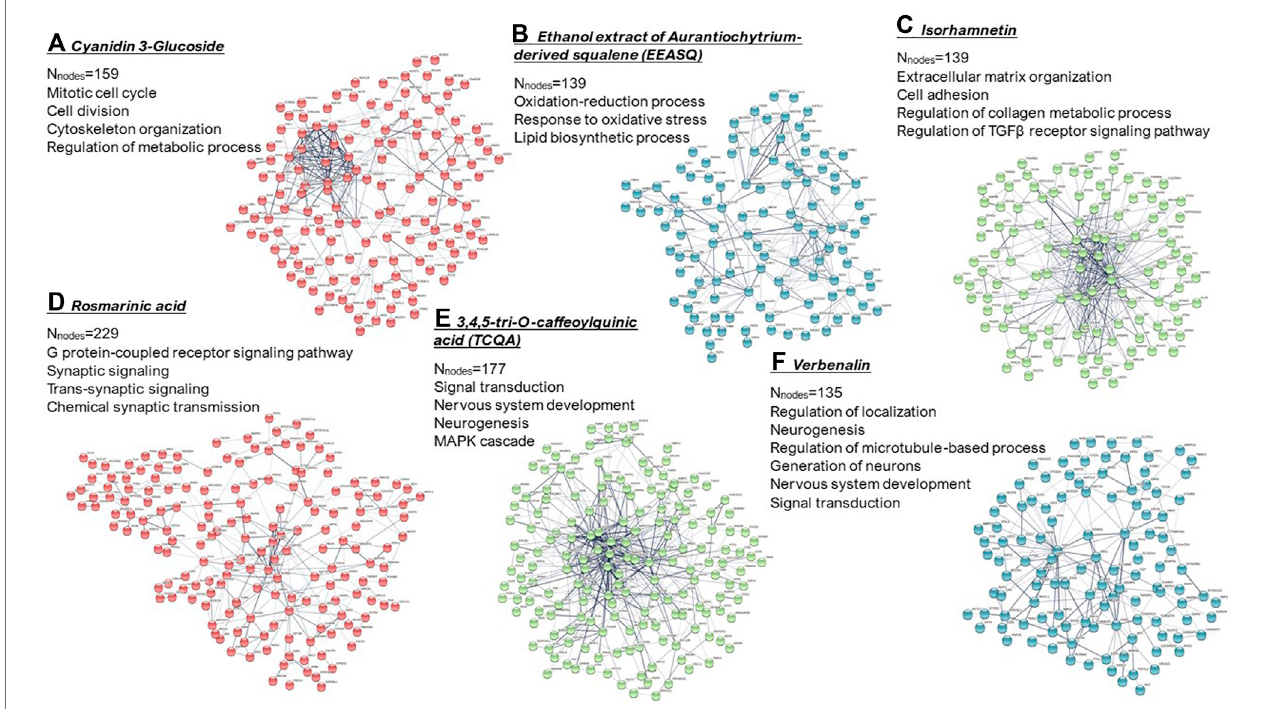
FIGURE2| k-meansclusteringandPPInetworkofthedifferentiallyexpressedgenes(computedusingSTRING;https://string-db.org/).Signi fi cantlyenrichedgene ontologies (biological processes) in each network are presented. N nodes = number of nodes. (A) Cyanidin 3-glucoside; (B) ethanol extract of Aurantiochytrium-derived squalene (EEASQ); (C) Isorhamnetin; (D) Rosmarinic acid; (E) 3,4,5-tri-O-caffeoylquinic acid (TCQA); (F) Verbenalin. Cells were treated with compounds for 7 – 10 days and RNAs were isolated from the control and treated hAESCs for microarray experiments using the Affymetrix ’ s GeneAtlas ® System (Affymetrix Inc., Santa Clara, CA,USA,humangenomearraystrips;HG-U219).Geneswithalinearfoldchange > 1.1(verbenalin),1.2(RA,TCQAandEEASQ),and2(ISO,CY3G)anda p -value < 0.05 (one-way between-subjects ANOVA) were considered as differentially expressed